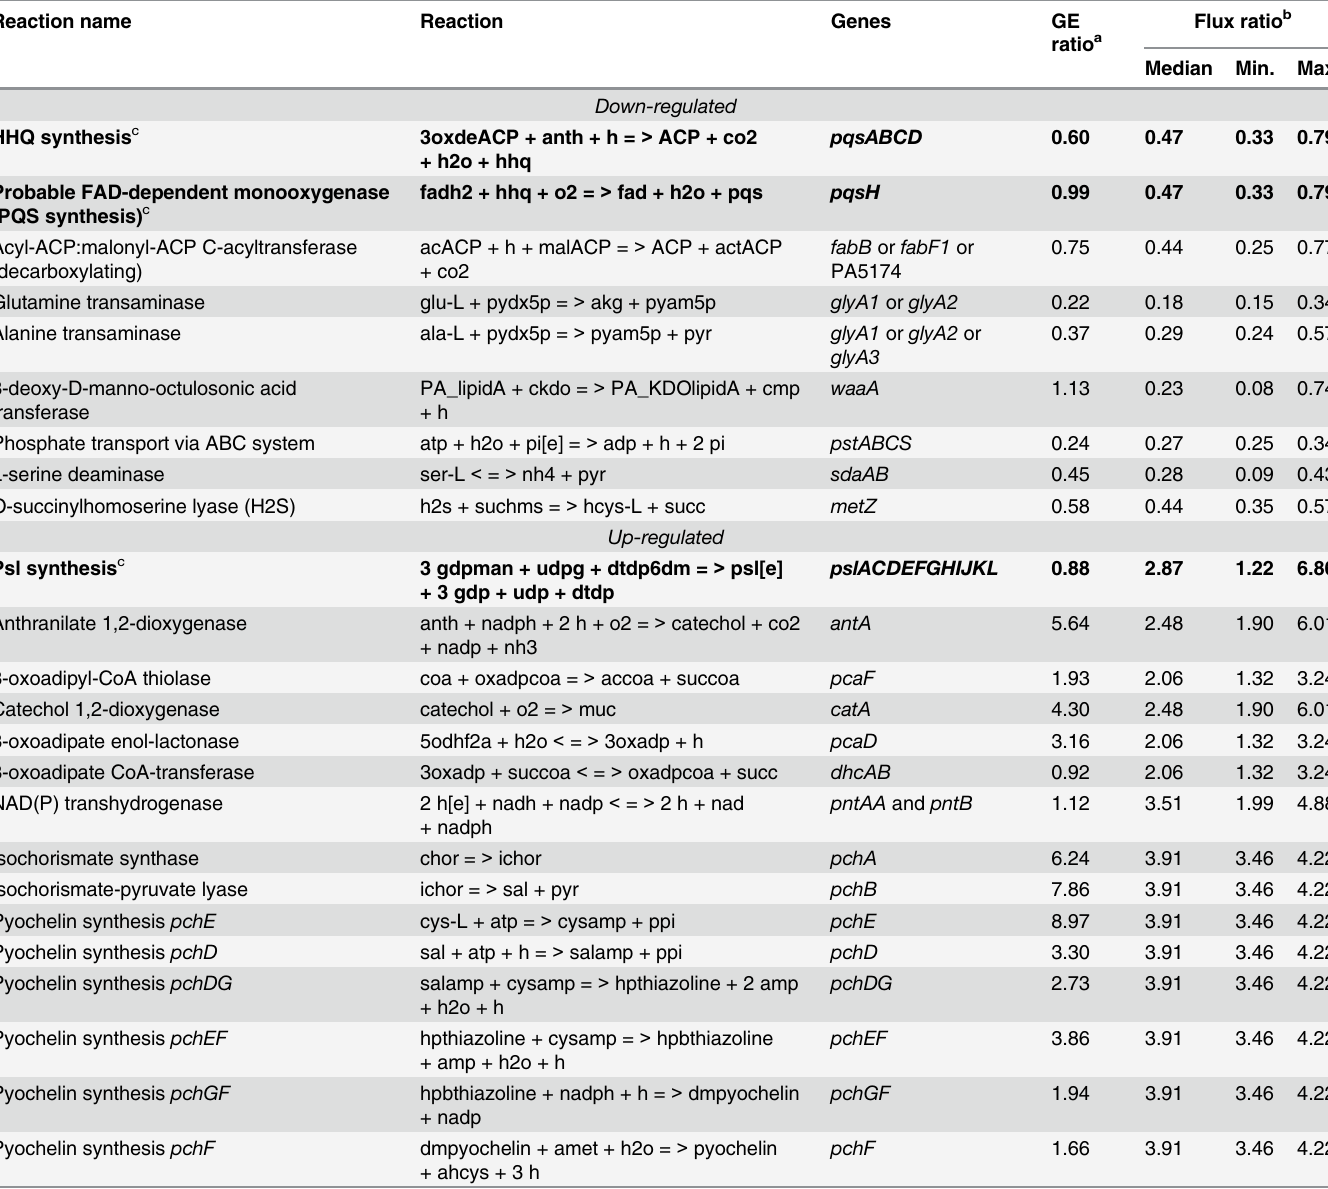
Table 2. Reactions with predicted median flux ratio change of at least 2-fold in biofilm cultures compared to stationary